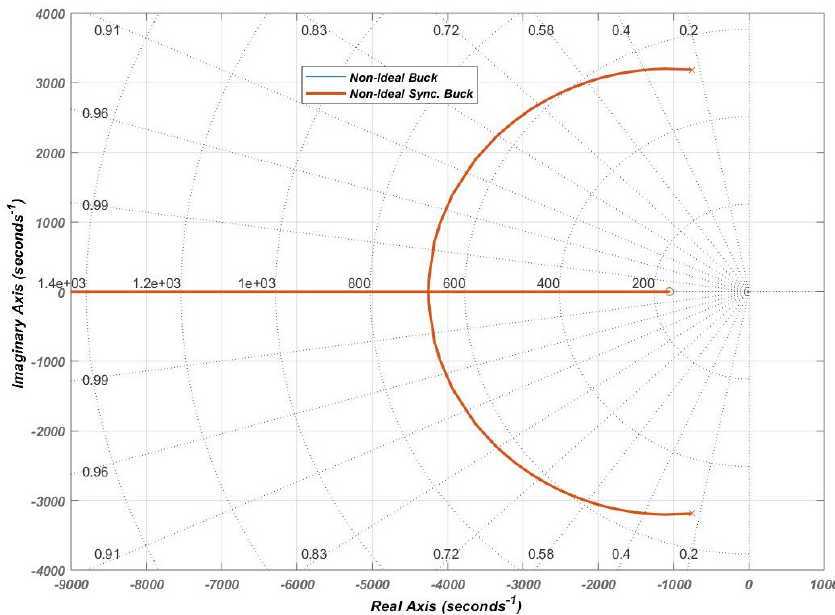
Figure 13. Root locus for non-ideal buck and synchronous buck converters.